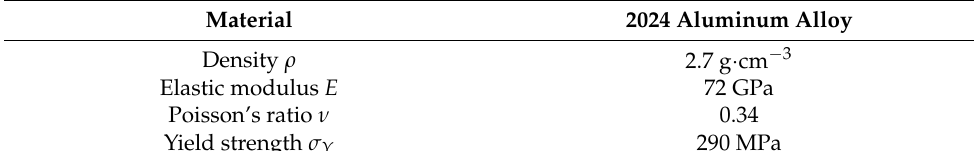
Table 2. Parameters of 2024 aluminum alloy.